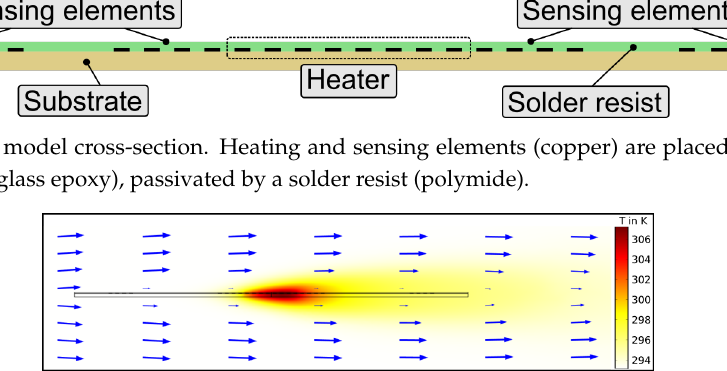
Figure 3. Results of the FEM simulation (for air as fluid) around the sensor. The colour indicates the temperature distribution for a heating power of 1W while the blue arrows indicate the flow velocity field at a velocity of 1m/s. Due to convection, the temperature profile is shifted